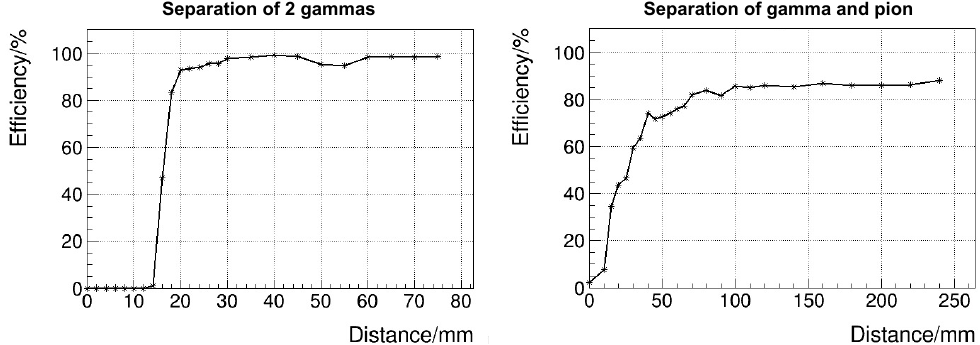
Figure 6. Preliminary study of separation efficiency with the dedicated reconstruction